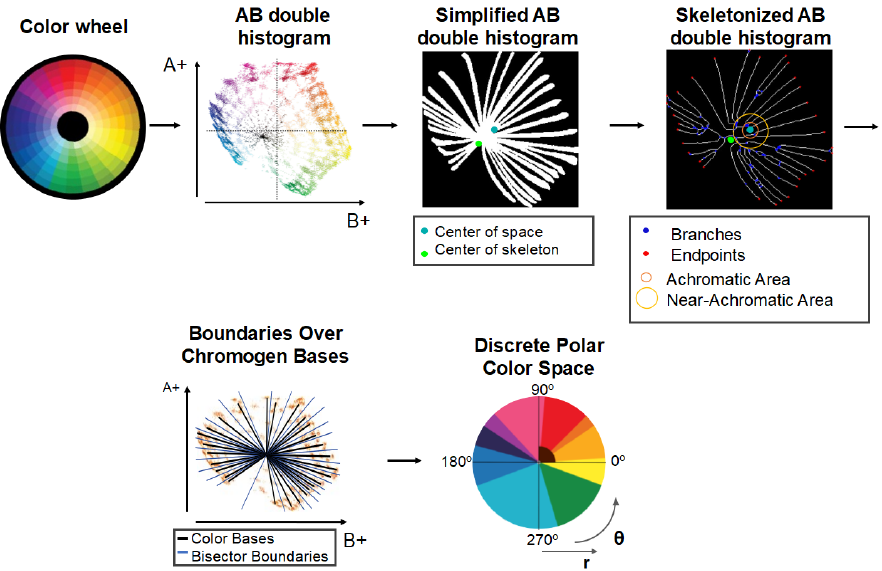
Figure A1. Complete version of the experiment shown in Figure 2A. Top row: from the color wheel, the AB double histogram was created; then, a simplified AB double histogram was computed and skeletonized, to find the color bases; the center of space and the center of the skeleton were marked with a green dot; the branches and the endpoints were marked with a blue and red point, respectively; the dark and the light orange circles indicate the positions of the achromatic (Scale of Grays) and near-achromatic (Brown) areas, respectively. Bottom row: the boundaries between the located color bases were chosen as each angle bisector; the final plot shows the proposed discrete polar color